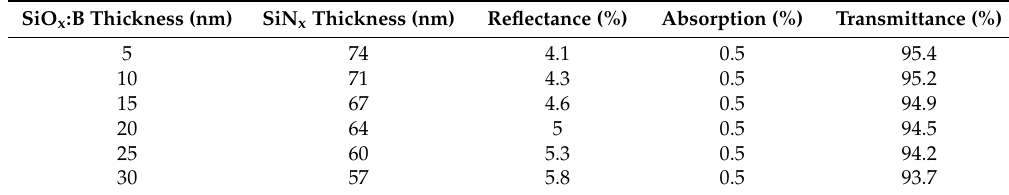
Table 2. Effect of different SiO x :B layer thicknesses on the optical